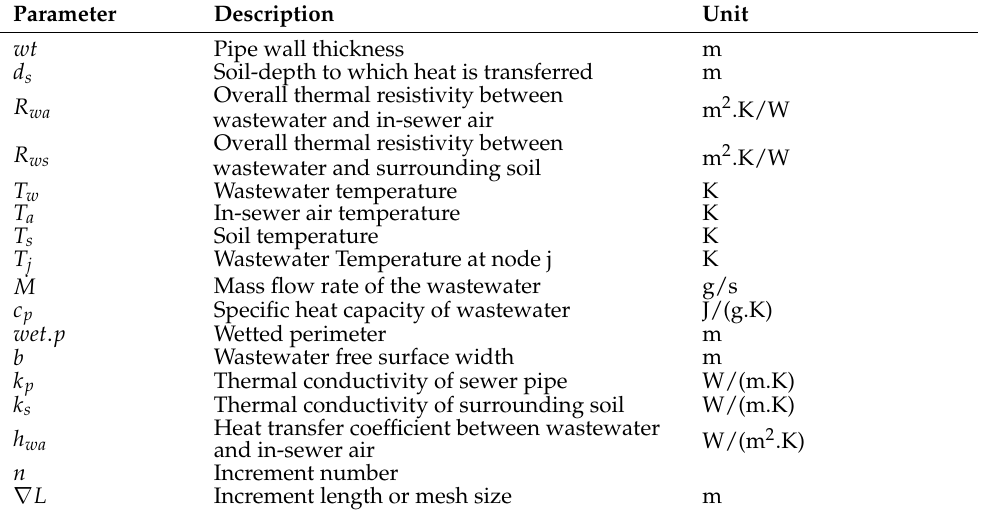
Table 5. Parameters description of Abdel aal et al.